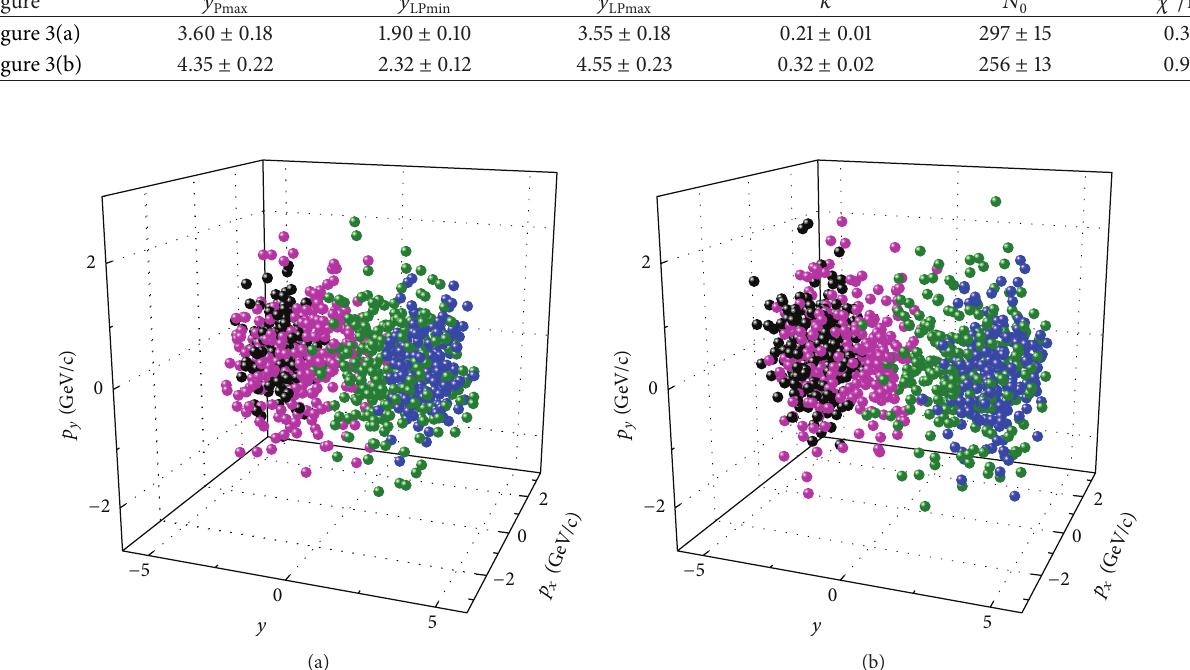
Figure 3: Scatter plots of 1000 net-baryons in 3D 𝑝 𝑥 - 𝑝 𝑦 - 𝑦 space in central Au-Au collisions at (a) 62.4 and (b) 200 GeV. The black, magenta, olive, and blue balls represent orderly the contributions of LT, TC, PC, and LP from low to high in the rapidity space due to different contribution